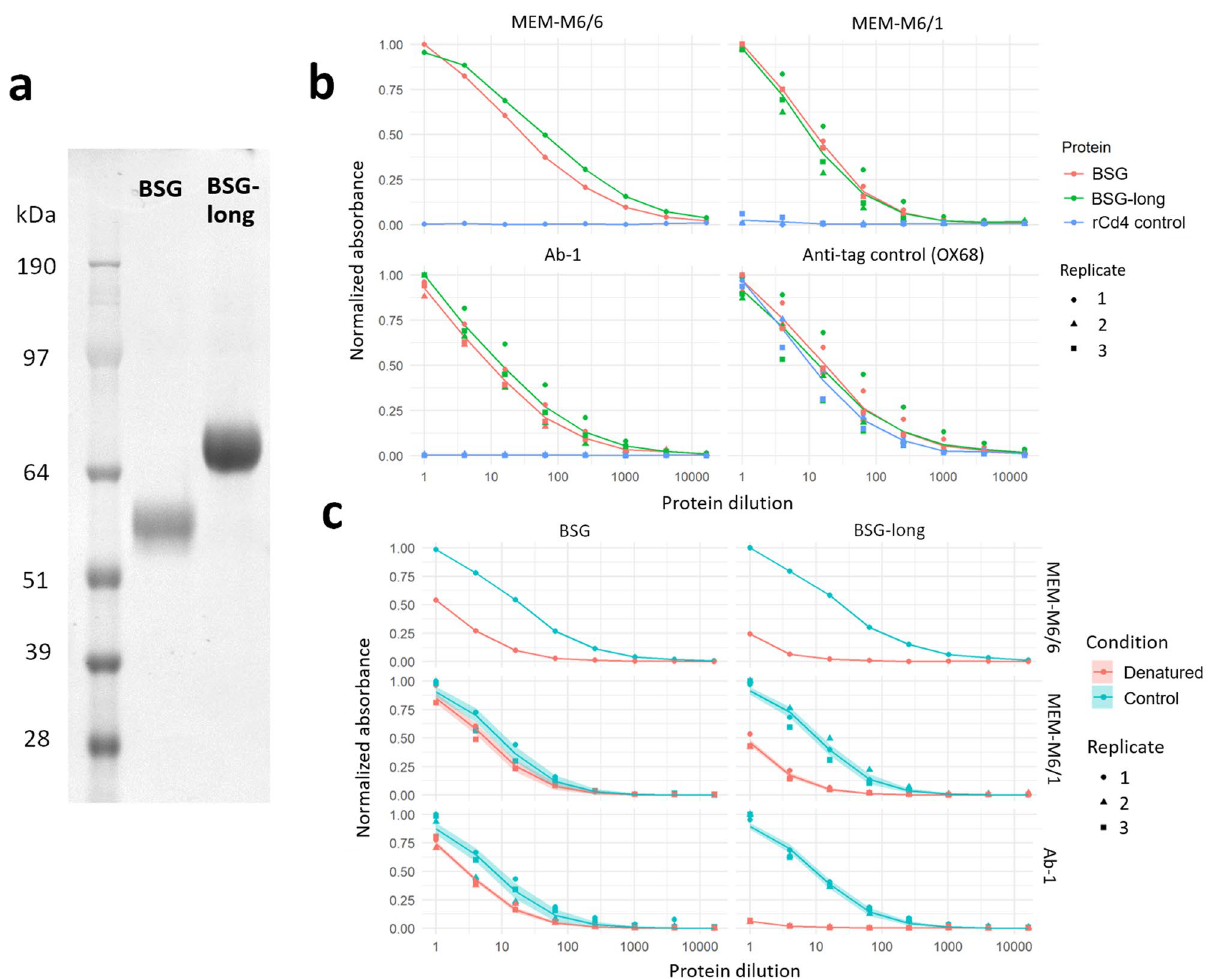
Figure 2. Basigin expressed as recombinant protein ectodomains retain their biochemical activity. ( a ) Expression and purification of two and three Ig-like domain isoforms of basigin. Proteins were resolved under reducing conditions by SDS-PAGE and stained with a Coomassie dye ( b ) . Recombinant basigin but not control proteins are recognized by anti-basigin monoclonal antibodies. ELISA dilution series of BSG and BSG-long recognized by three different monoclonal antibodies, and a control OX68 antibody against their tags. A negative control of a recombinant Cd4 tag is included for each antibody. ( c ) Recombinant basigin retains folded conformation of epitopes recognized by three different monoclonal antibodies. ELISA dilution curves comparing unmodified basigin to protein treated with heat and a reducing agent. Three replicates were performed for all ELISA curves except MEM-M6/6, for which only a single trial was done. Dose response curve model fit lines are superimposed on the data points, with shading indicating the 95% confidence bounds of the